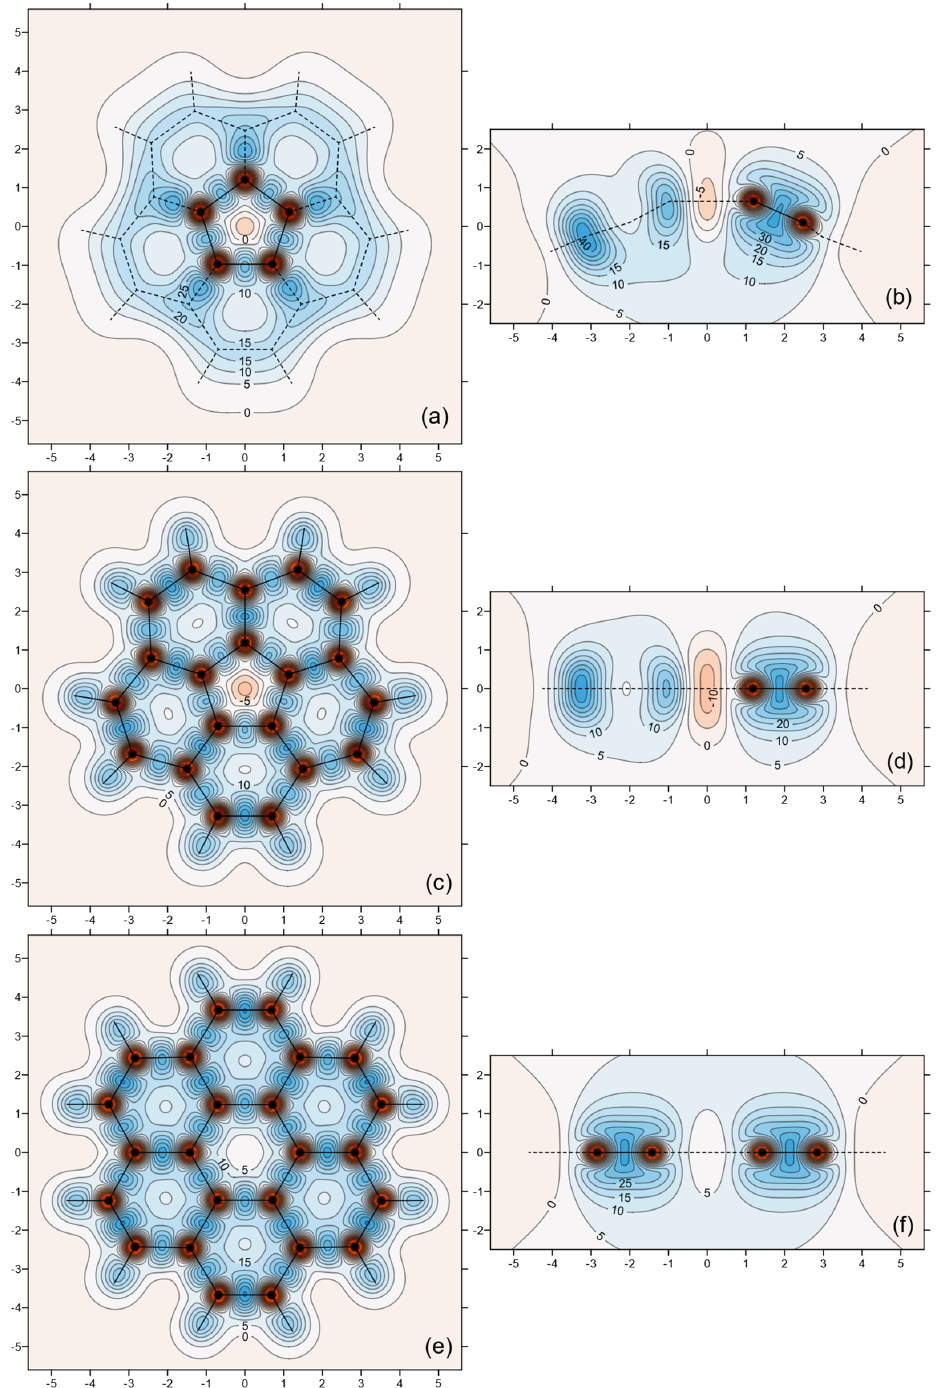
Figure 4. Isotropic shielding contour plots in the plane passing through the hub carbons ( a ) and a σ v symmetry plane ( b ) for C 5v corannulene; the molecular (horizontal) planes ( c , e ) and σ v symmetry planes ( d , f ) for D 5h corannulene and D 6h coronene, respectively. Dashed lines show projections of bonds not in the plotting plane. Distances in Å, contour levels at an interval of 5 ppm, red (deshielded) to blue (shielded).